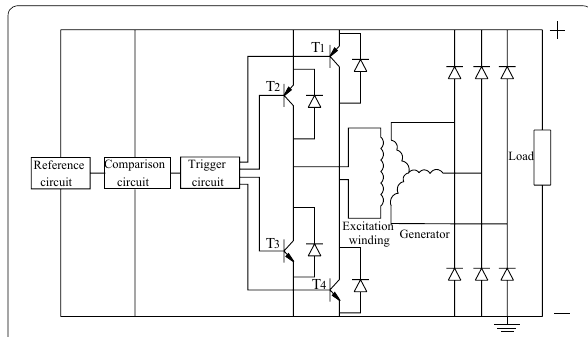
Figure 16 Circuit principle diagram of electromagnetic coupling regulator controller